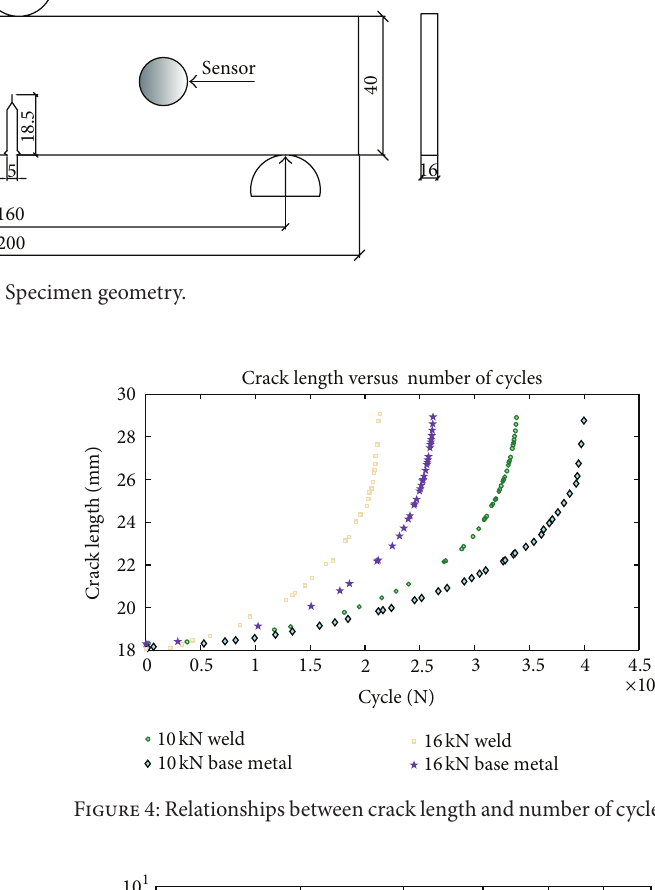
Figure 2: Experimental setup.